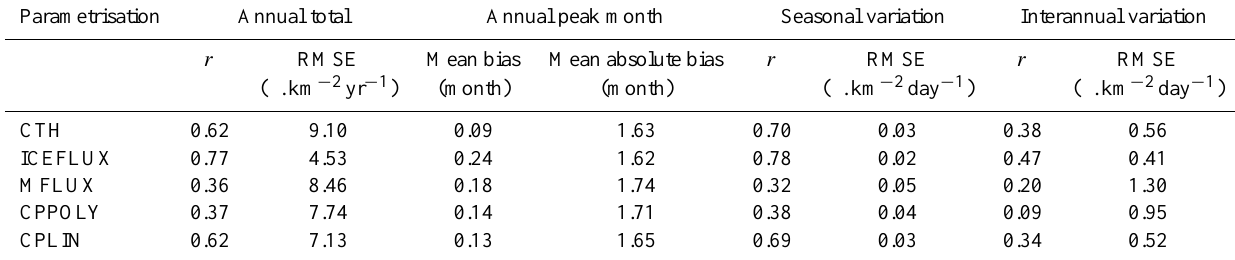
Table 1. Statistics of annual total spatial distribution, peak timing and interseasonal and interannual spatial distributions. For the spatial distributions, the correlation ( r ) and root mean square error (RMSE) are given.